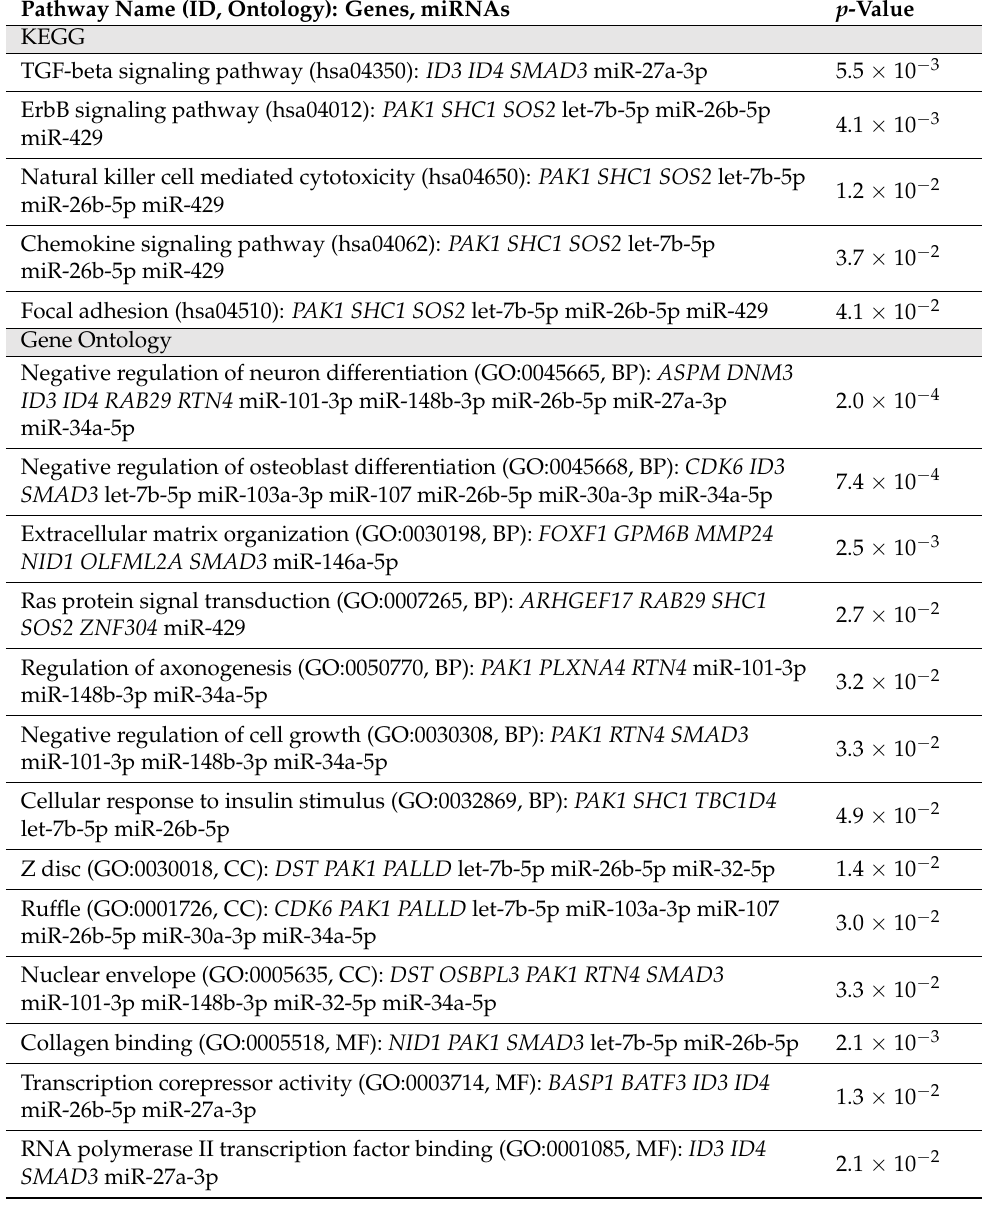
Table 2. Enriched pathways for network